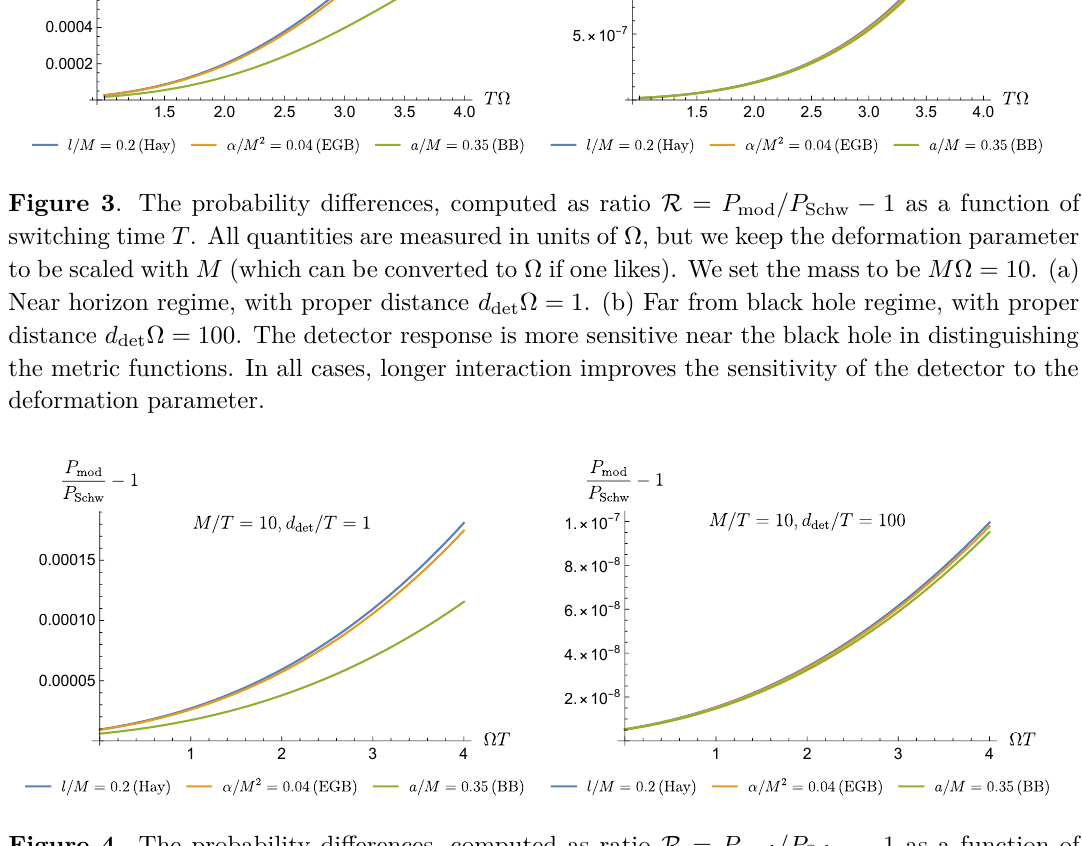
Figure 4 . The probability differences, computed as ratio R = P mod /P Schw − 1 as a function of energy gap Ω . This time, all quantities are measured in units of T , but we keep the deformation parameter to be scaled with M . We set the mass to be M/T = 10 . (a) Near horizon regime, with proper distance d det /T = 1 . (b) Far from black hole regime, with proper distance d det /T = 100 . As before, the detector response is more sensitive near the black hole in distinguishing the metric functions. In all cases, larger energy gap improves the sensitivity of the detector to the deformation parameter. Although qualitatively similar to figure 3, the scales are